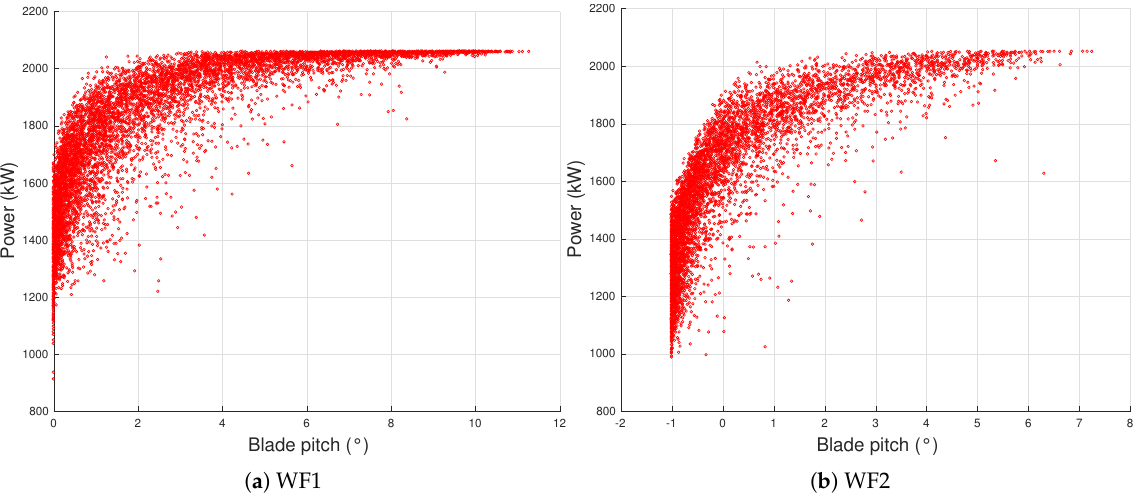
Figure 5. An example of blade pitch-power curve for T1 in WF1 and